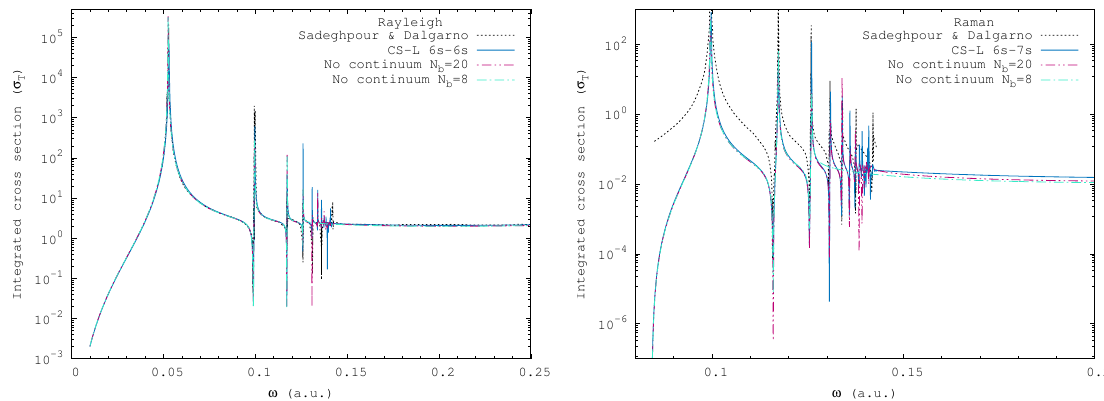
Figure 10. Length gauge cross sections for Rayleigh and Raman scattering on the ground state of cesium with comparison to the length gauge calculations of Sadeghpour and Dalgarno [12]. We demonstrate convergence of our cross sections with respect to increased number of intermediate bound states and account of continuum. N b denotes the total number of bound intermediate